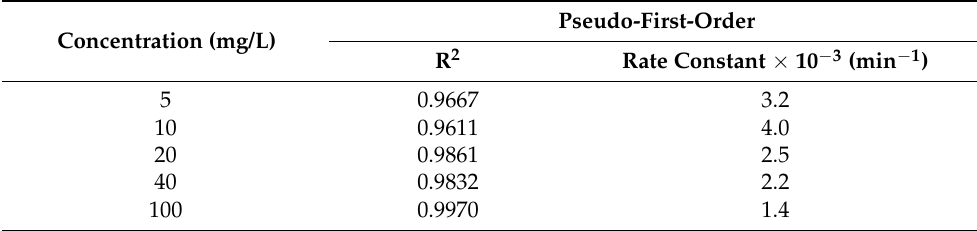
Table 4. Pseudo-first-order rate constants showing the effect of dye concentration on the photocat- alytic activity.